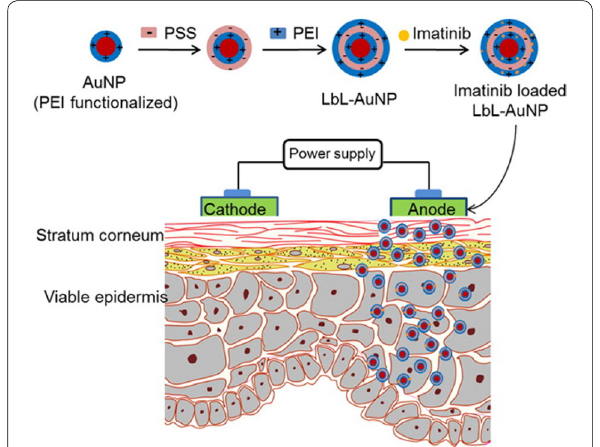
Fig. 5 A schematic of the cancer drug, Imatinib Mesylate being encapsulated in the multilayer coated PEI/PSS/PEI AuNPs, showing the use of iontopherisis for topical delivery into the layers of the skin. Reprinted from Ref. [48] with permission from the American Chemical